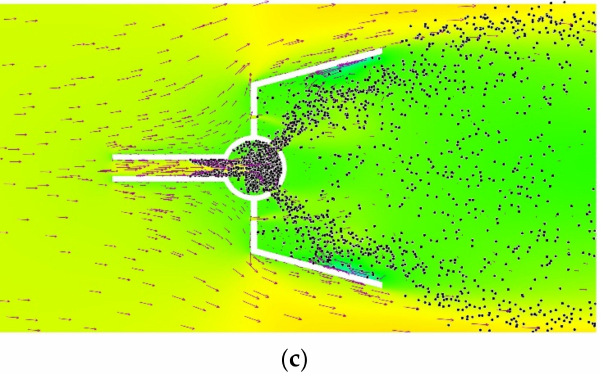
Figure 10. Spray field at different actuation dimensions: ( a ) 20 mm, ( b ) 10 mm, ( c ) 5 mm with 45 kV and 14 kHz.